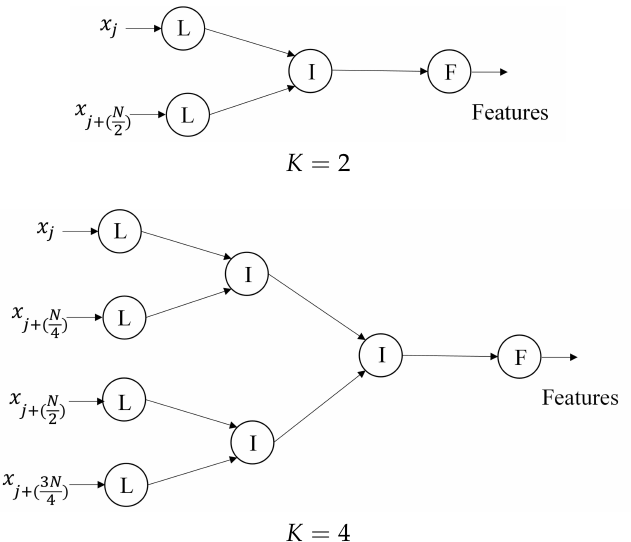
Figure 12. The binary tree representation of the proposed architecture for parallel computation with K = 2 and 4. The nodes denoted by L, I and F are the leaf nodes, intermediate nodes and root nodes,